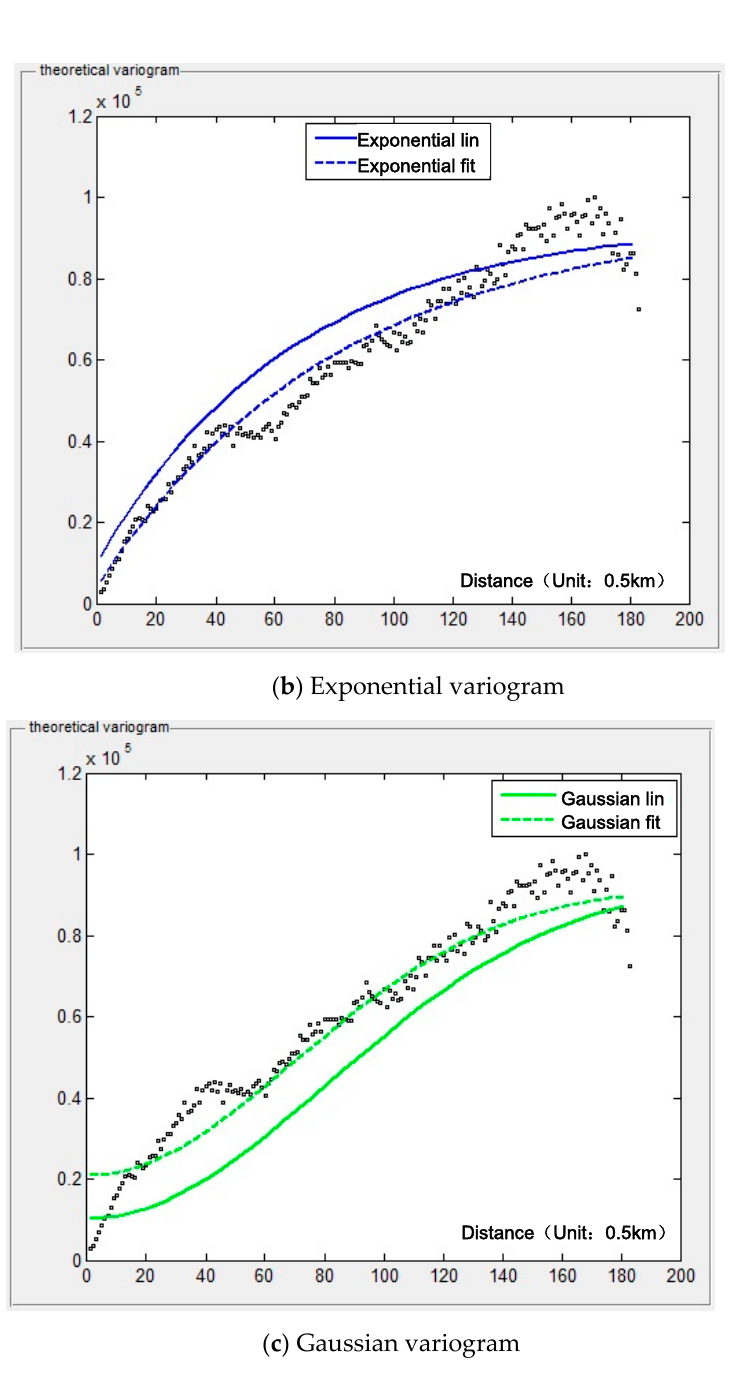
Figure 4. Three variogram fitting results of WEEE return in simulation example.